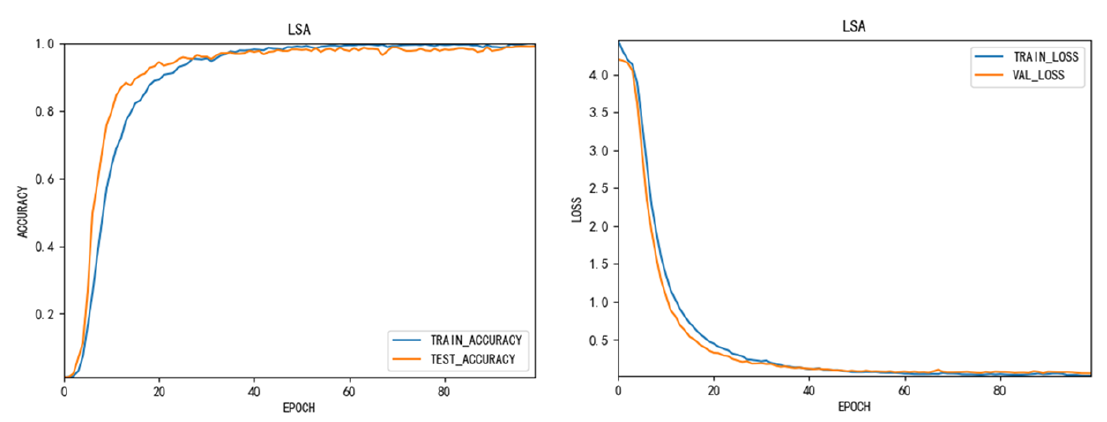
Figure 3. Accuracy on LSA dataset using MEMP network.